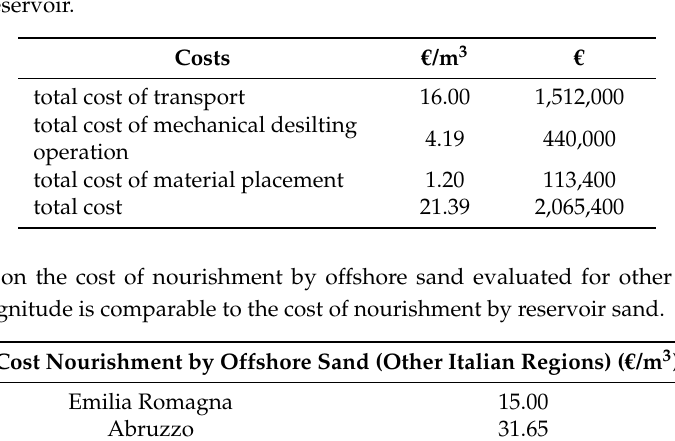
Table 7. Cost items and total cost for the yearly beach nourishment by material dredged from the Guardialfiera Reservoir.